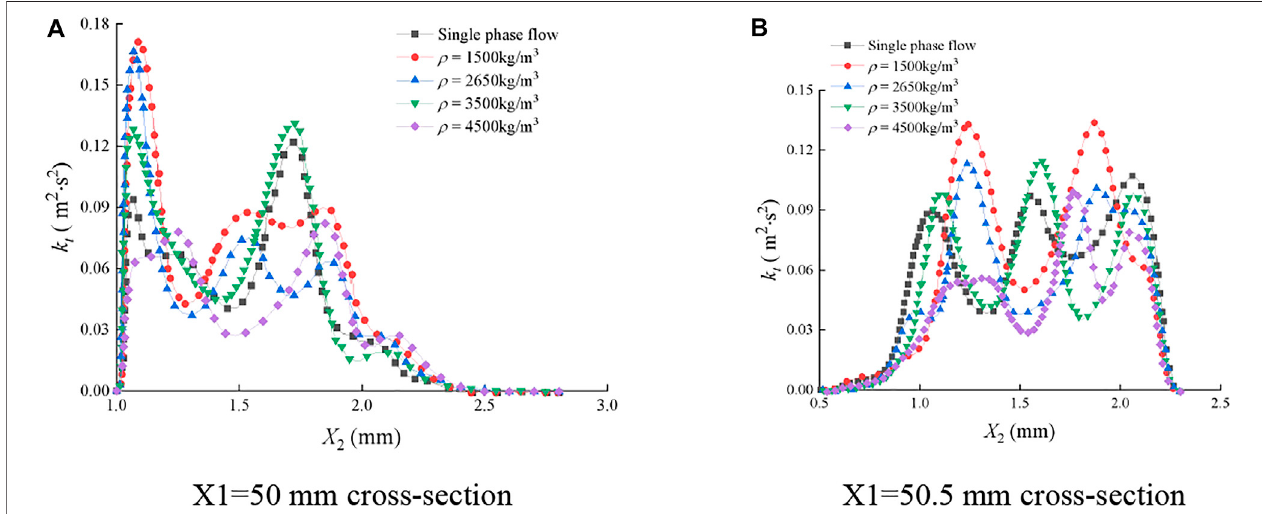
FIGURE 19 | Distribution of turbulent kinetic energy of the continuous-phase fl uid on cross sections of the rough fracture. (A) X1=50 mm cross section; (B) X1=50.5 mm cross section.